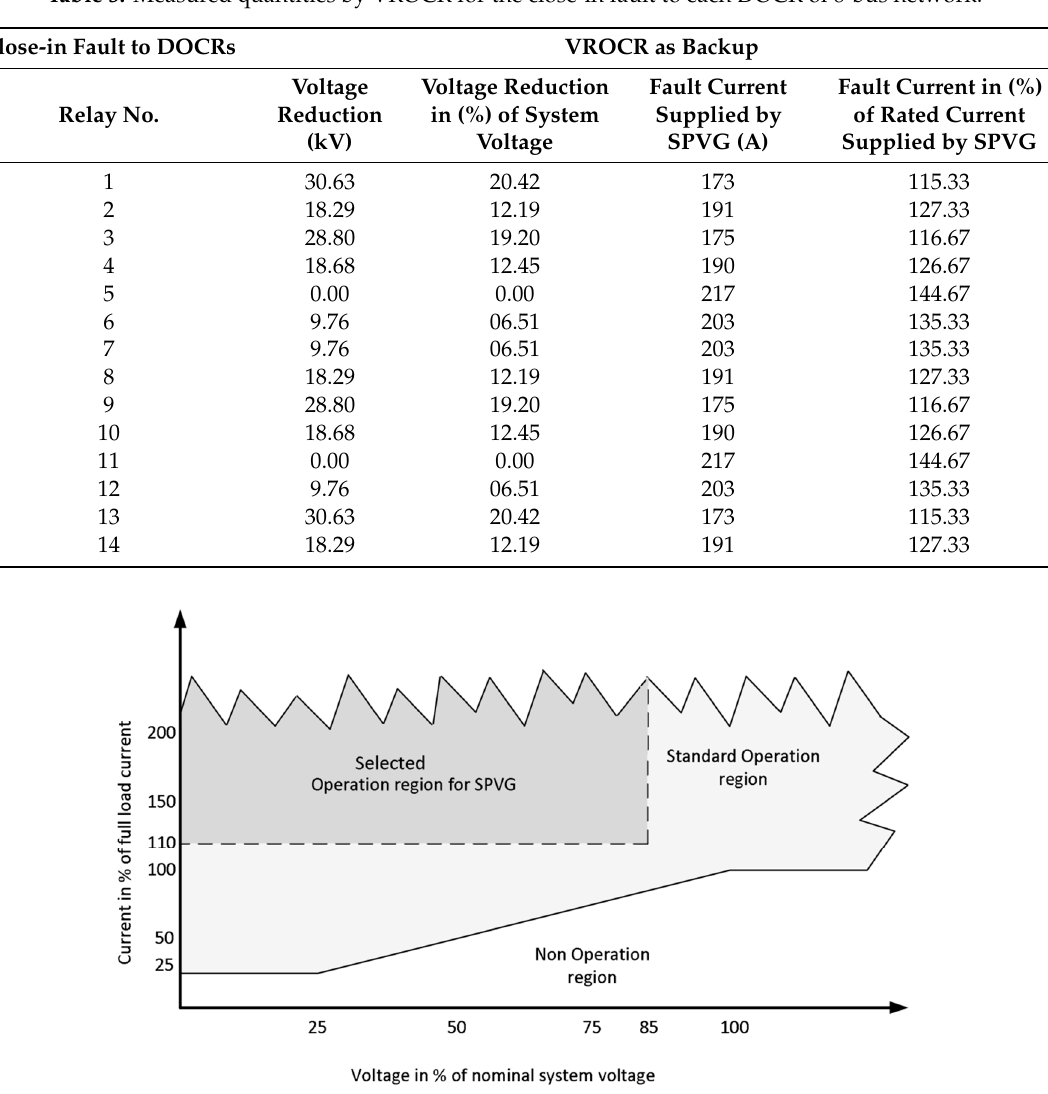
Table 3. Measured quantities by VROCR for the close-in fault to each DOCR of 8-bus network.